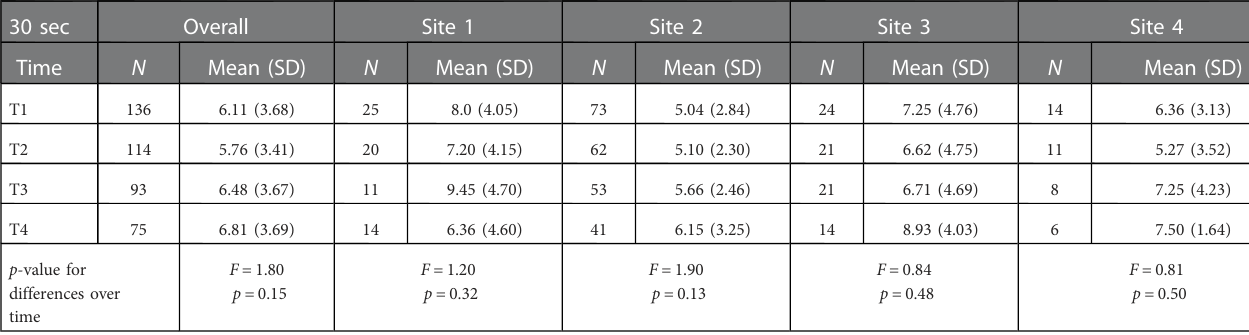
TABLE 2 PIPP-R scores at 30 seconds after the procedure over